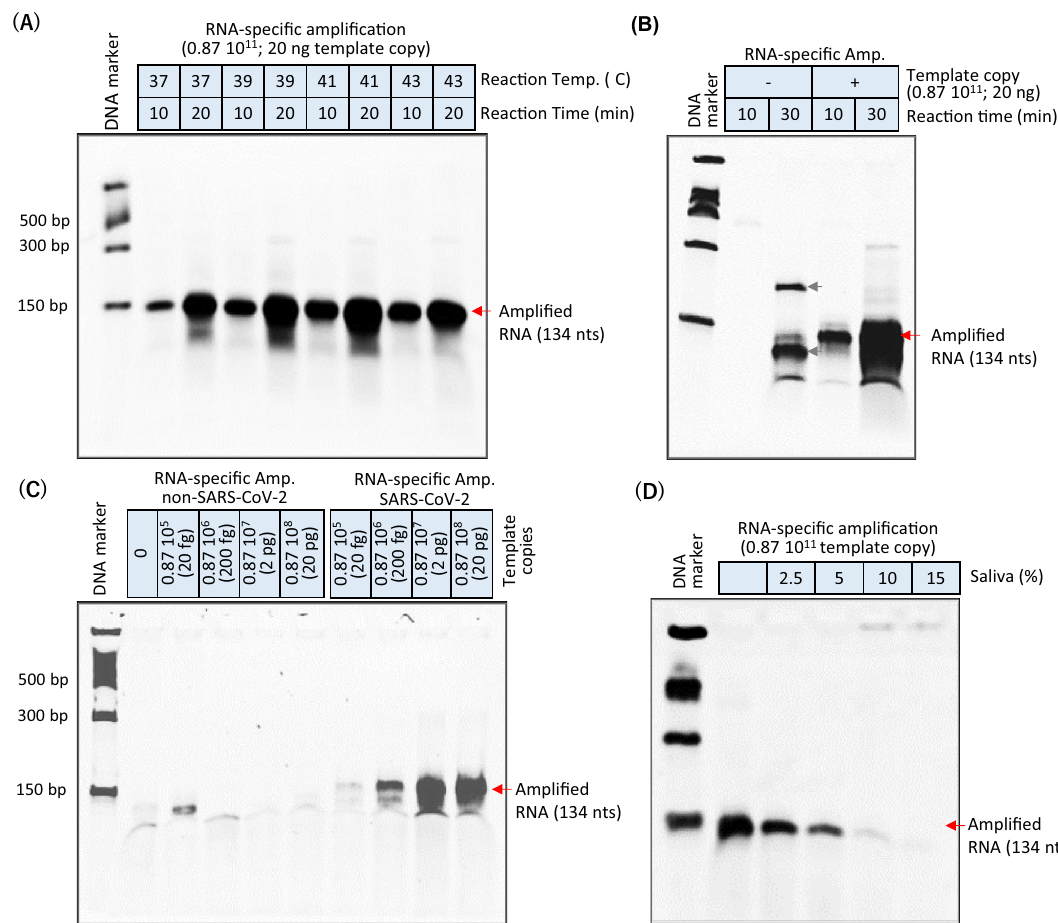
Figure 4. Optimization of antisense strand RNA amplification. ( A ) The effect of temperature in the range of 37–43 °C on the reaction efficiency of RNA amplification was checked at 10 and 20 min. ( B ) The specificity of RNA amplification was evaluated with high (10 11 ) or no template copy numbers and shorter (10 min) or longer (30 min) reaction times. ( C ) Evaluation of the selectivity of RNA amplification for the detection of the targeted template (SARS-CoV-2) over a longer template (non-SARS-CoV-2) at a copy number range of 10 5 –10 8 with a 10-min reaction incubation time. ( D ) The inhibition effect of saliva on the reaction efficiency of RNA amplification was tested in the range of 2.5 to 15% saliva in the reaction. Red and gray arrows indicate true- positive (134 nt) and false-positive amplified products,